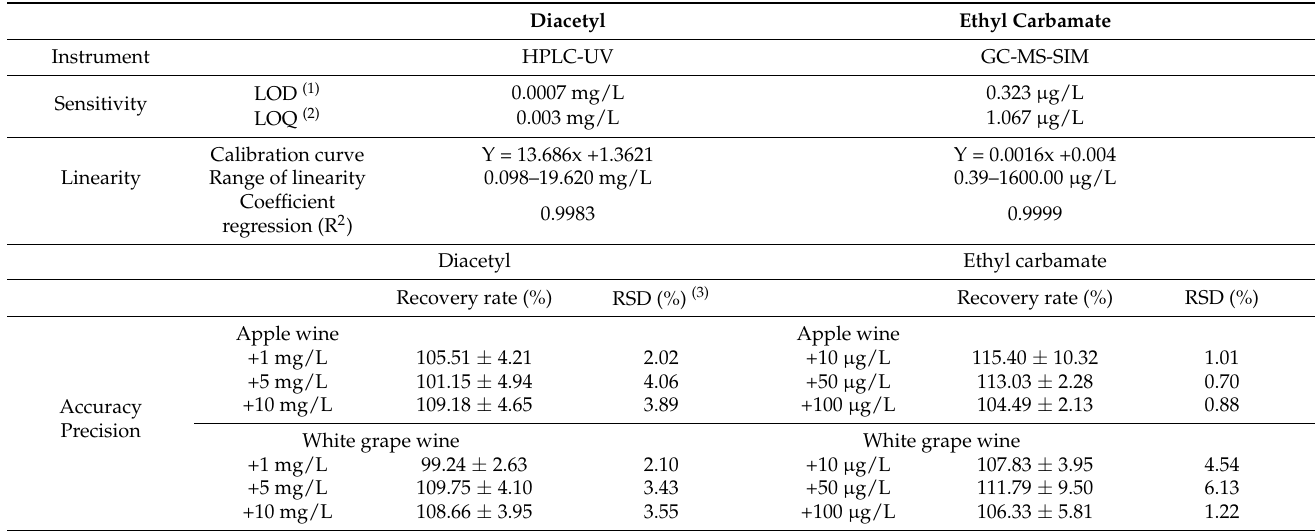
Table 6. Method validation of diacetyl and ethyl carbamate